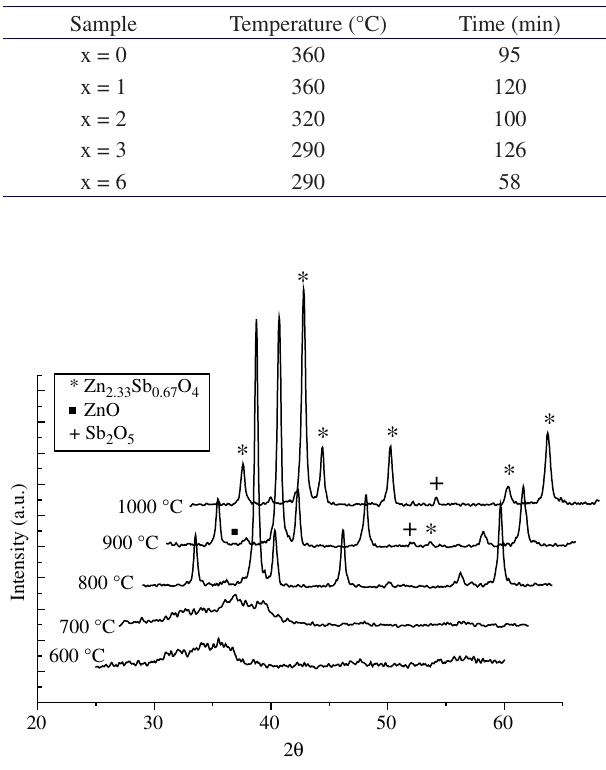
Sb O as a funciton of tem- 7 2 12